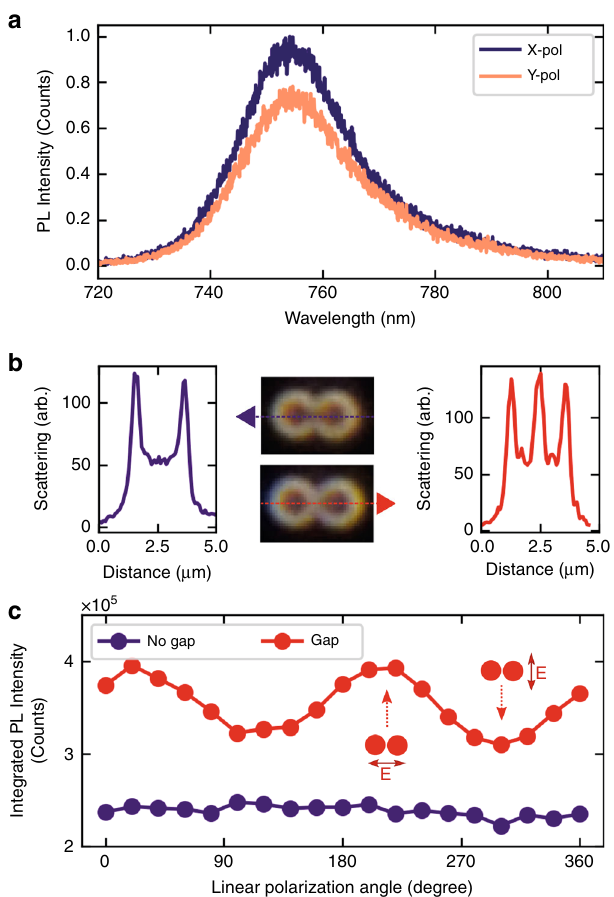
Fig. 3 Polarisation properties of WSe 2 coupled to GaP nano-antennas. a Photoluminescence spectra for 1L-WSe 2 on a GaP nano-antenna ( g = 65 nm, r = 400nm) for a laser excitation linearly polarised along X - and Y -axes of the dimer (de fi ned as in Fig. 1). b Dark- fi eld microscopic images and related scattered light intensity pro fi les for two GaP nano- antennas ( r = 400nm) covered with 1L-WSe 2 . The scattered light intensity pro fi les are taken along the long axes ( Y ) of the dimer as shown by the dotted lines. The top (bottom) images and left (right) graphs correspond to the dimers without (with) a gap. c Comparison of 1L-WSe 2 PL intensity as a function of the orientation of linearly polarised excitation for the nano- antennas in b . Red (dark blue) shows the dependence for the dimer